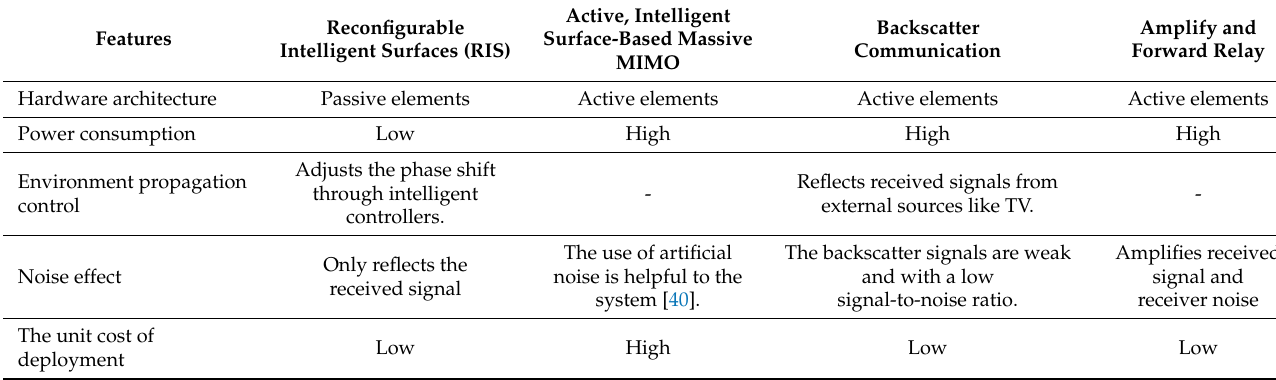
Table 1. A comparative analysis of RIS features with other relay systems.